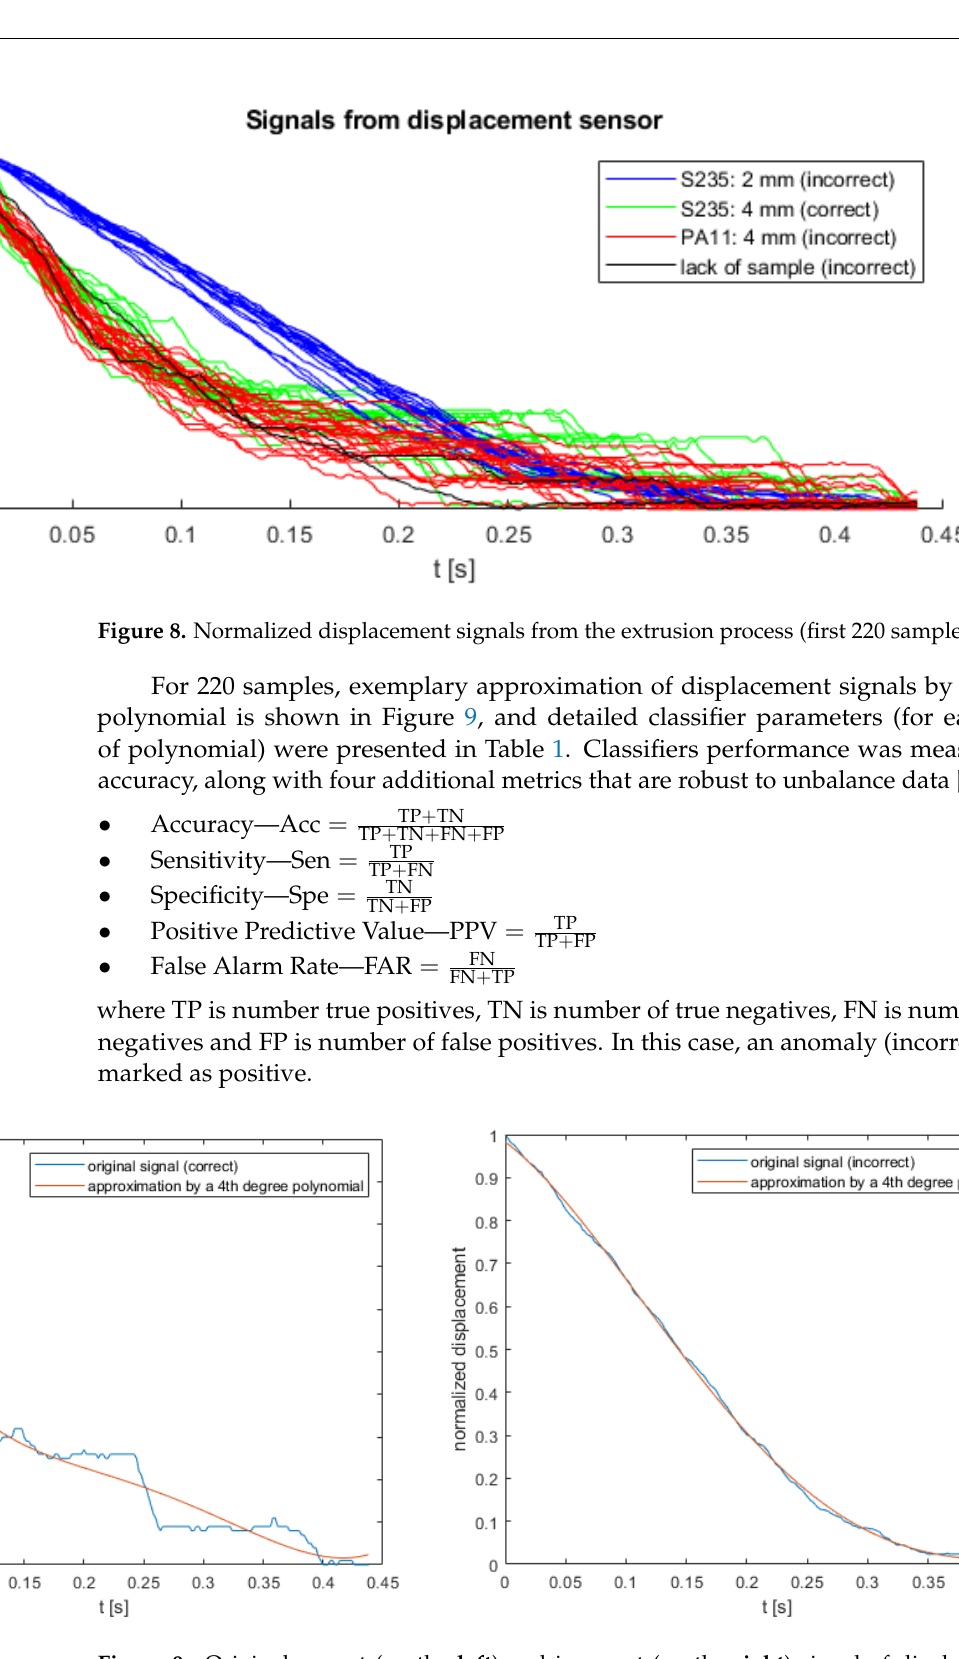
Figure 7. Classification accuracy in relation to the signal length and the minimum degree of the polynomial to achieve the indicated accuracy.